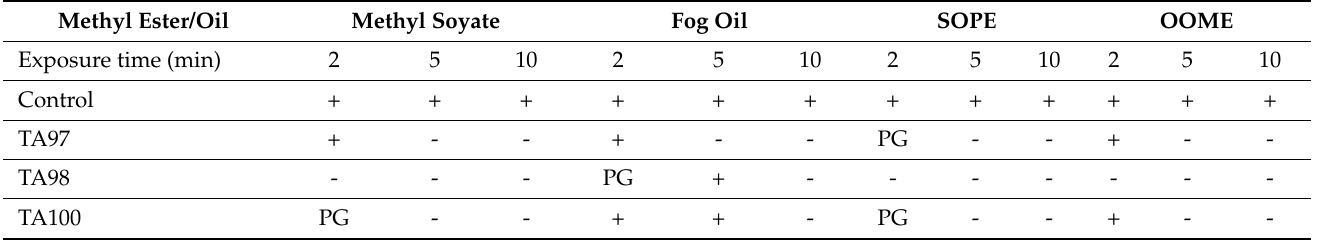
Table 2. Relative antibacterial activities of vegetable oil esters and fog oil vapors.